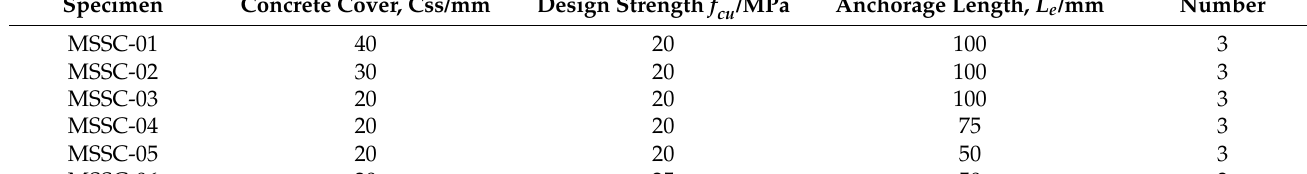
Table 1. Specimen parameters.